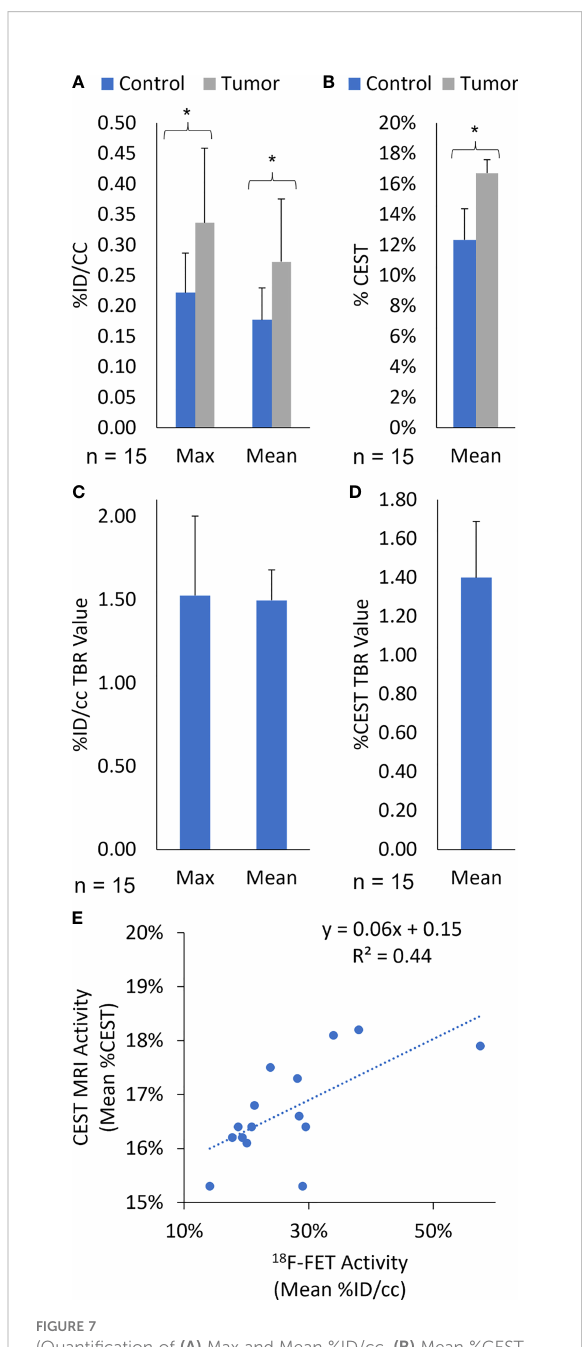
FIGURE 7 (Quanti fi cation of (A) Max and Mean %ID/cc, (B) Mean %CEST, (C) Max and Mean %ID/cc TBR, and (D) Mean %CEST TBR for 18 F-FET PET/MRI on day 49 post-implantation. All Rag2 -null